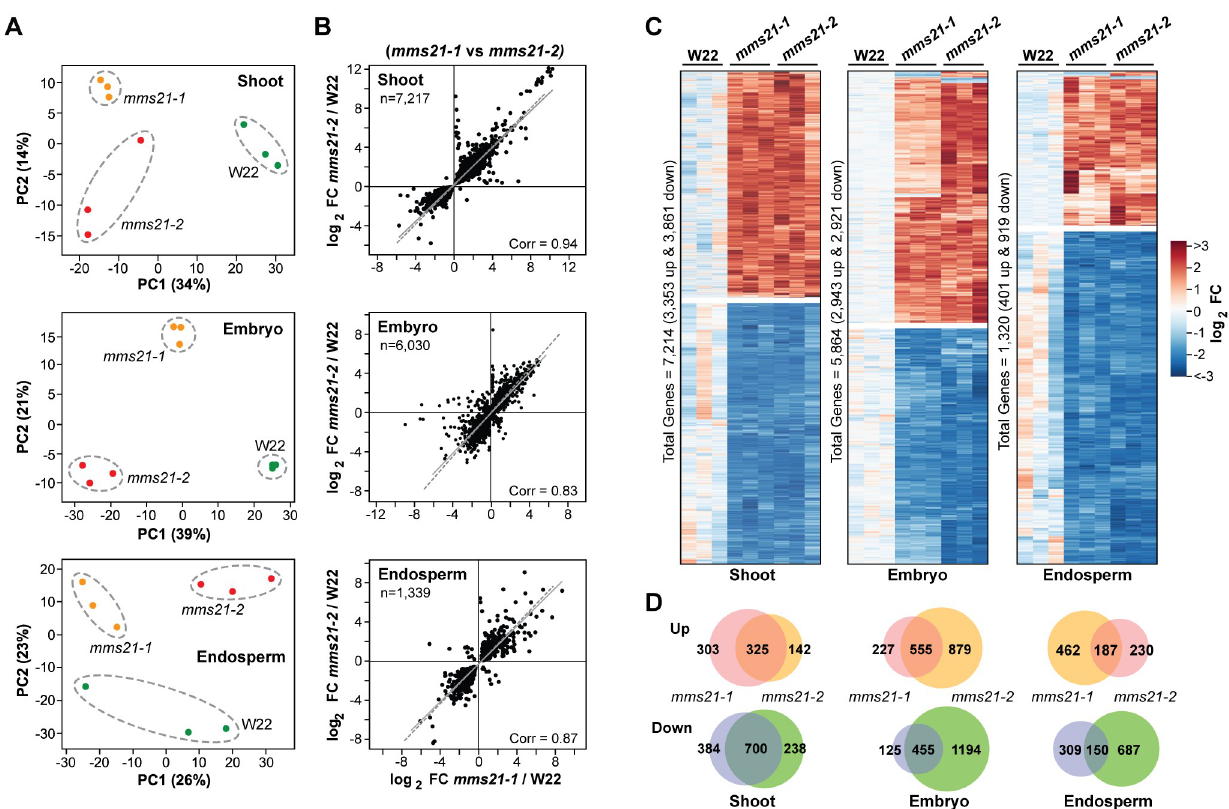
Fig 5. The mms21-1 and mms21-2 Mutations Profoundly Alter the Maize Transcriptome. mRNA profiles were generated by RNA-seq from W22, mms21-1 , and mms21- 2 shoots collected at 10 DAS, and from embryos and endosperm isolated at 16 DAP. (A) PCA of the transcriptome data sets showing that the mms21-1 and mms21-2 mRNA profiles differ from W22. The values were determined from log 2 -transformed transcript counts for each dataset (n = 3 biological replicates). The dashed lines outline biological replicates associated with each genotype. (B) Scatterplots of significantly affected transcripts (adjusted p -value < 0.05) in the two mms21 alleles versus those in W22. The total numbers of significantly affected transcripts analyzed are indicated, along with Pearson’s correlation coefficient (Corr) values. Solid lines show the correlation within each comparison; dashed lines show correlations equal to 1. Each point represents the mean of three biological replicates. (C) Heat maps showing the read counts for shoot, endosperm, and embryo transcripts significantly affected by each mms21 allele, as determined by DESeq2 using an adjusted p -value < 0.05. The abundances for each allele were normalized to the average values obtained from W22. (D) Venn diagram showing the overlap of transcripts significantly affected in mms21 versus W22 shoots, embryo and endosperm as determined by the adjusted p -value < 0.05 and a FC � 2-fold up or